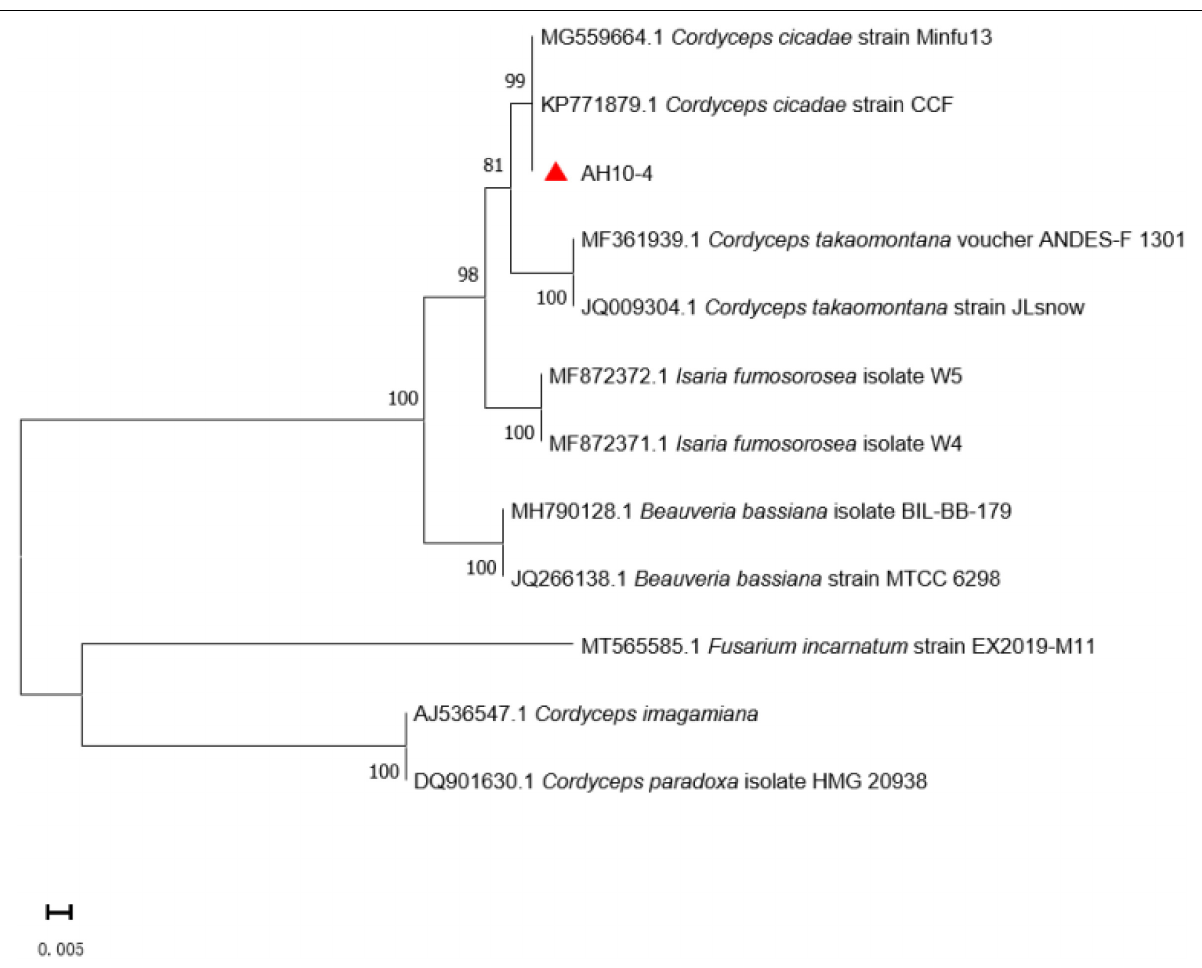
FIGURE 6 | Phylogenetic tree of strain AH10-4. Evolutionary distances were assessed using the neighbor-joining method. Phylogenetic tree shows that AH10-4 belongs to the Cordyceps cicadae . GenBank accession numbers for ITS sequences are placed before the taxon name. Fusarium incarnatum were designed as the